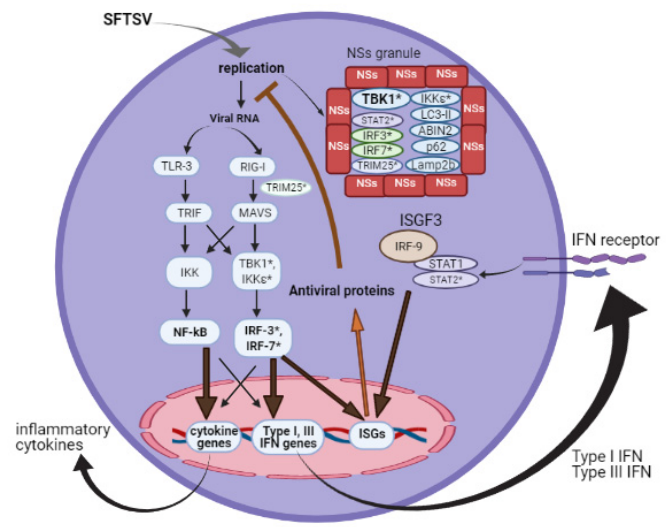
Figure 1. Type I IFN antagonism by SFTSV NSs. In virus-infected cells, various viral RNA species are sensed by TLR3 and RLR to initiate a signaling cascade for antiviral responses. NSs protein can intrinsically form cytoplasmic granules that entrap several factors involved in antiviral responses (* indicates such factors).